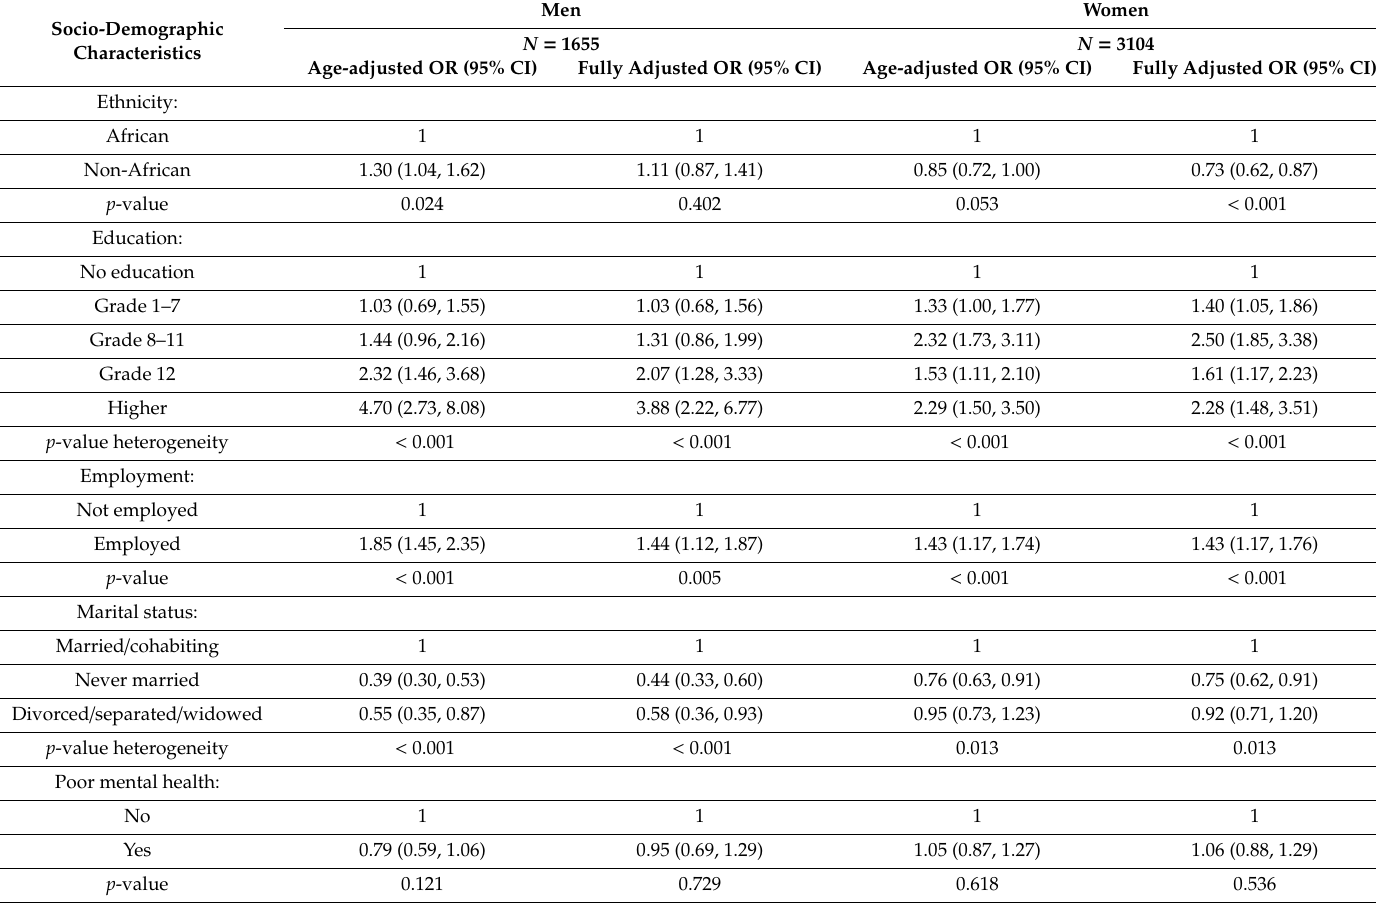
Table 7. Relative risks of overweight or obesity among 1655 men and 3104 women from the SANHANES study in 2012; by indicators of socioeconomic position (results from logistic